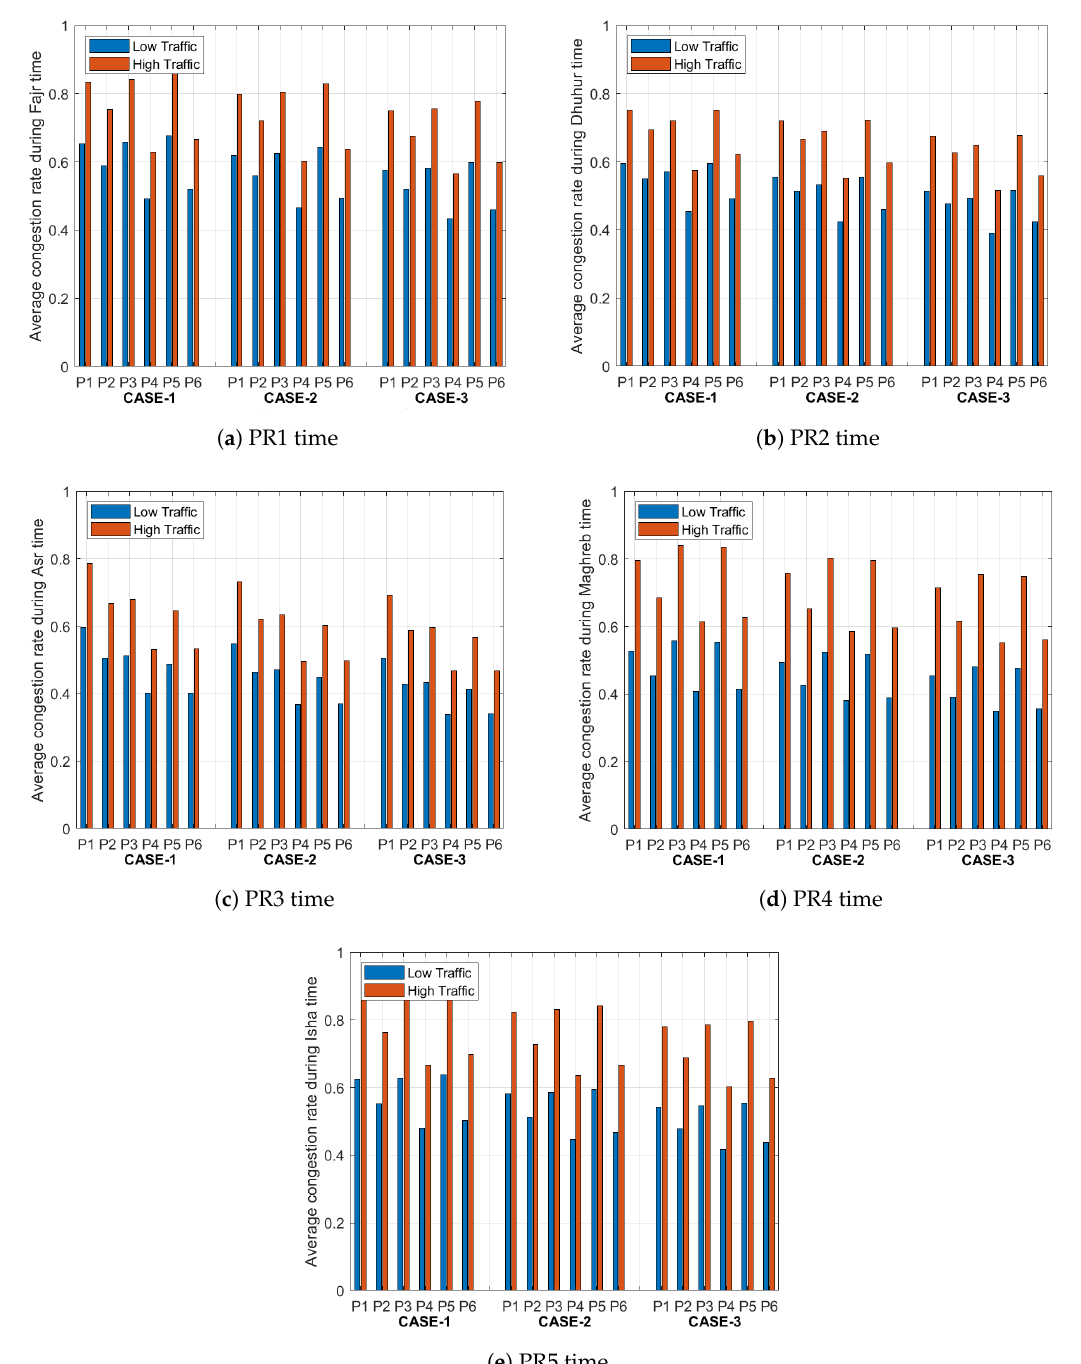
Figure 7. Average congestion rates for all paths to the six parking lots (P1, P2, P3, P4, P5 and P6) for the five time periods